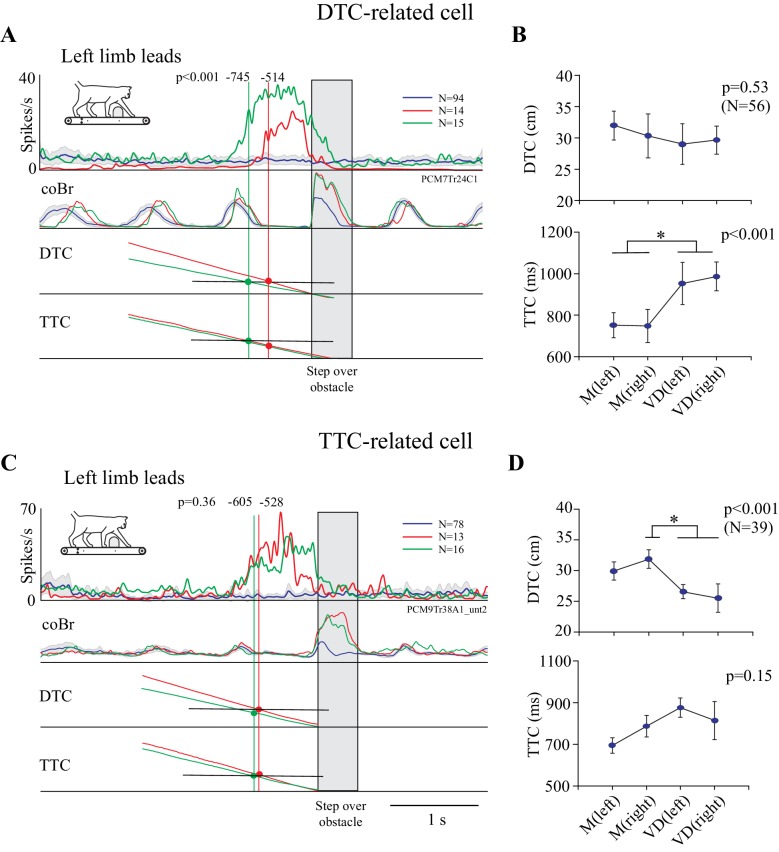
Relationship of cell discharge onset to distance and time (individual examples).A and C show two examples of cell discharge in the unobstructed (blue line), matched (red), and visual dissociation (green) task in the left limb leads condition, together with traces indicating DTC and TTC of the head from the obstacle. A is the same cell as in Figure 3. The vertical green and red lines are aligned with the average onset of cell discharge as calculated from individual trials (values indicated at the top of each line). Their intersection with the DTC and TTC traces is indicated with colored circles. The probability that the onset of cell activity during the matched and visual dissociation tasks is the same is indicated by the p-value. (B,D) Plots of the average DTC (top graph) and TTC (bottom graph) (±interval of confidence at p=0.05) for the matched and visual dissociation task in the lead and trail conditions. Results of an ANOVA are shown to the top right of each graph and asterisks indicate significant differences between left and right lead and matched (M) and visual dissociation (VD) tasks (Bonferroni correction, p<0.05). Plots for DTC and TTC in B,D are scaled to the same range (Figure 4—source data 1 and 2).10.7554/eLife.28143.012Figure 4—source data 1.Source data for Figure 4B.10.7554/eLife.28143.013Figure 4—source data 2.Source data for Figure 4D.10.7554/eLife.28143.014Figure 4—source code 1.Script for data in Figure 4.